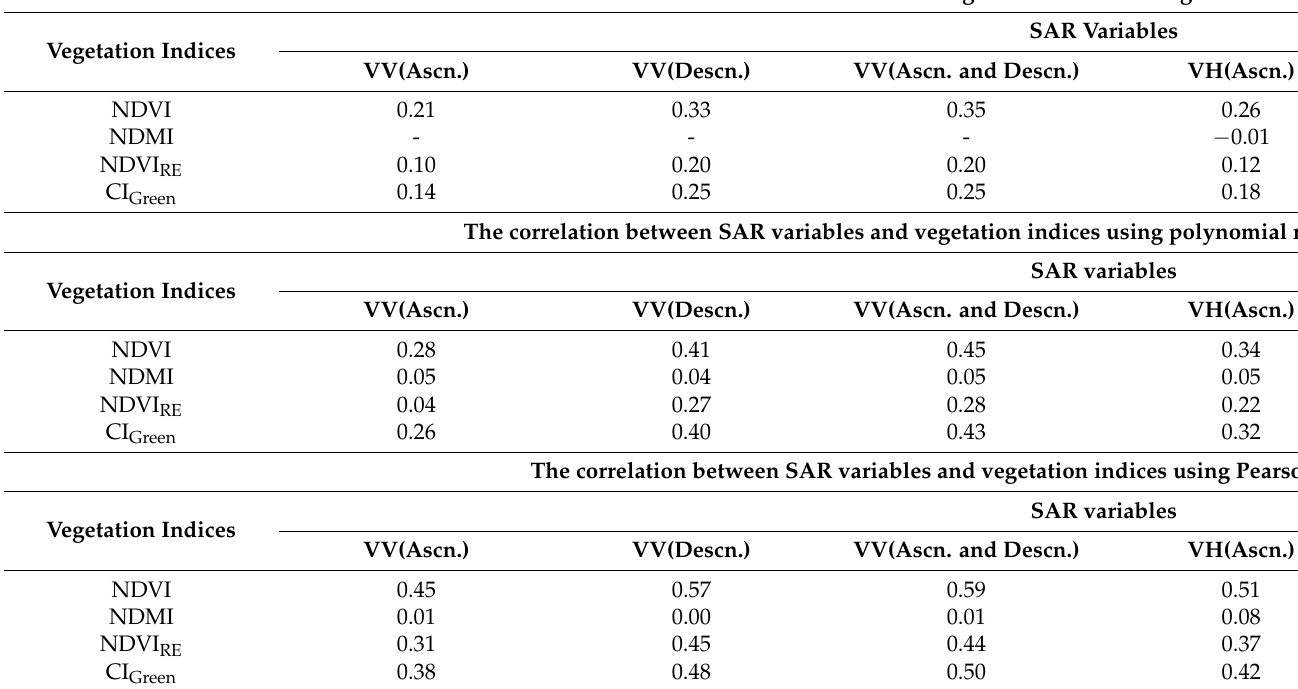
Table 6. Comparison of Correlations Between SAR Variables and Vegetation Indices Using Different Models. The Correlation between SAR Variables and Vegetation Indices Using Linear Regression